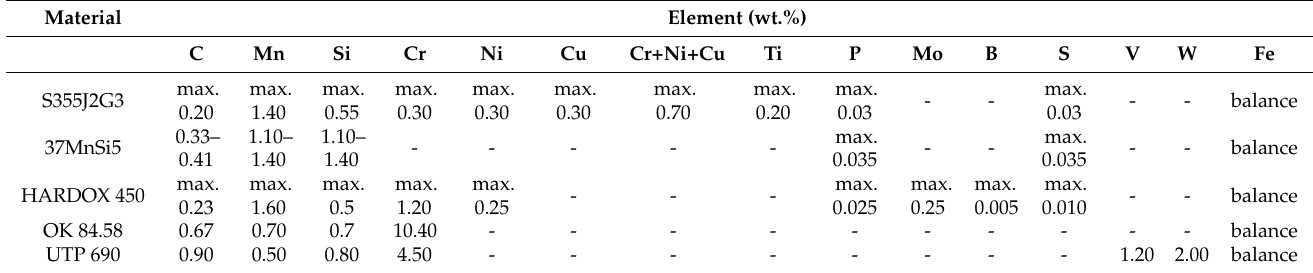
Table 3. Chemical composition of S355J2G3 [24], 37MnSi5 [25], HARDOX 450 [27] steels and